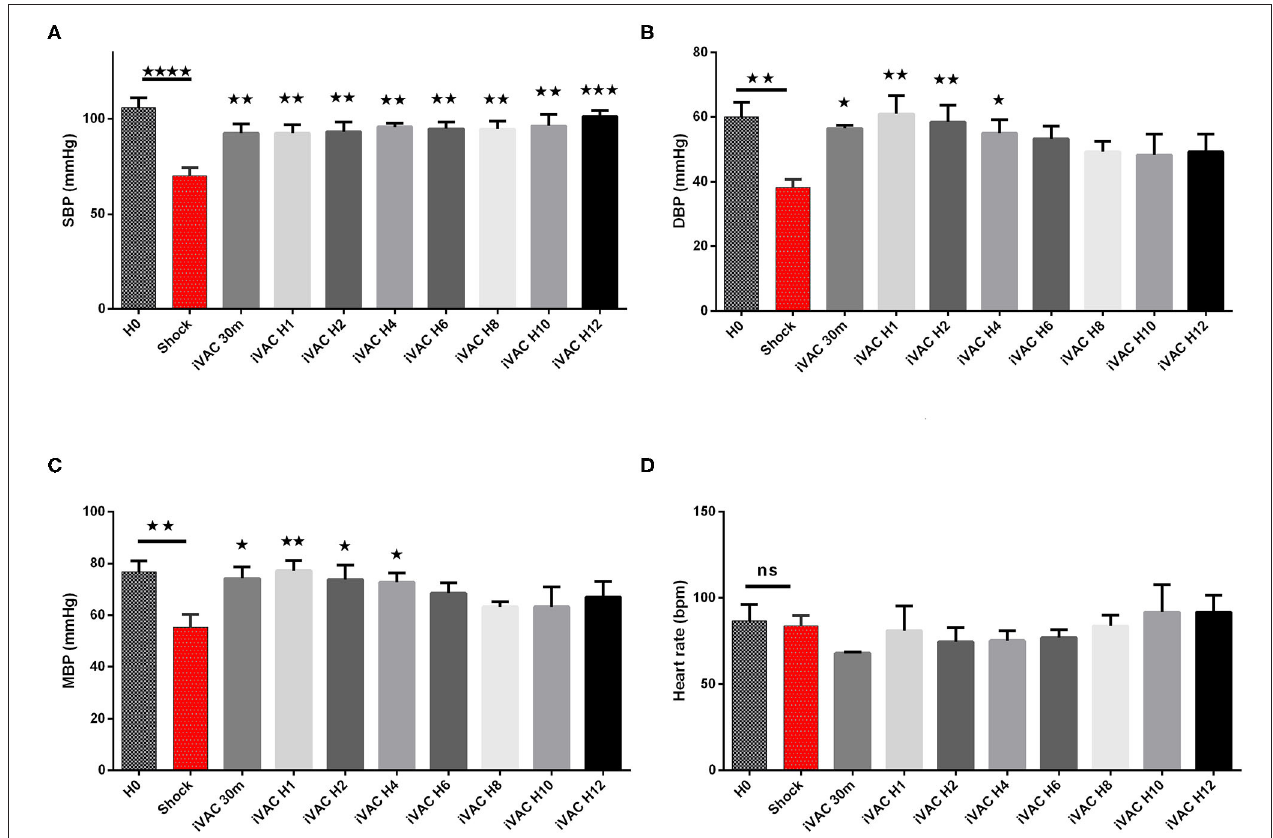
FIGURE 5 | Hemodynamic parameters of IVAC2L support efficiency in CS pigs. Systolic blood pressure (A) , diastolic blood pressure (B) , mean blood pressure (C) and heart rate (D) are presented here. Parameters are presented as mean ± SEM ( n = 4). The values of p were obtained by comparing the first baseline data to CS data, and second by comparing CS to others time points under IVAC2L support to CS onset (H4, H12). ⋆ p < 0.05; ⋆⋆ p < 0.01, ⋆⋆⋆ p < 0.001 vs. shock, and ⋆⋆⋆⋆ p < 0.0001. H0, baseline; H1, 1h post CS; H4, 4h after cardiogenic shock; H12, 12h after CS. DBP, diastolic blood pressure; H0, baseline; HR, heart rate; MBP, mean blood pressure; SBP, systolic blood pressure; SEM, standard error of